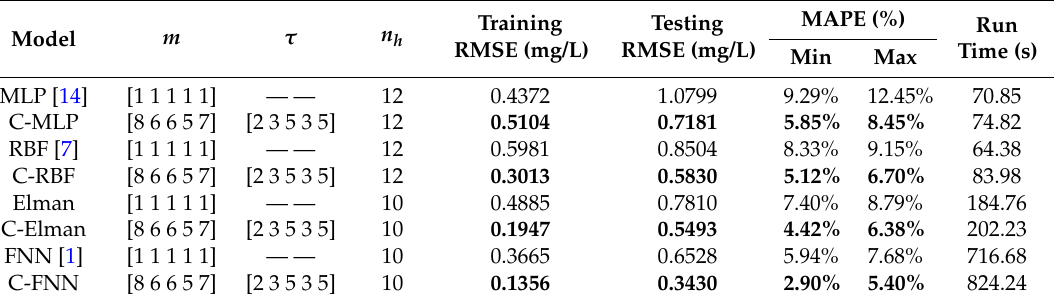
Table 3. The performance comparison of different